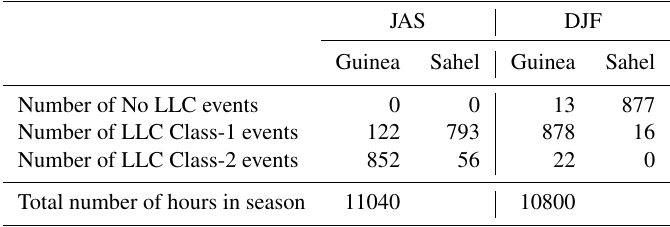
Table 2. Number of events found for the occurrence of the three LLC classes in JAS and DJF. Composite analysis is performed based on these events for each class and season. For the study period, the total number of daytime hours are 11040 and 10800 in JAS and DJF,